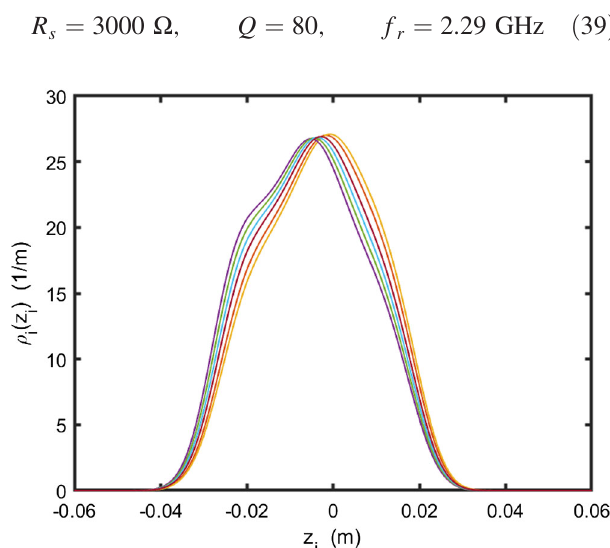
FIG. 16. Fit of Im Z to Lorentzian and LRC circuit formulas.